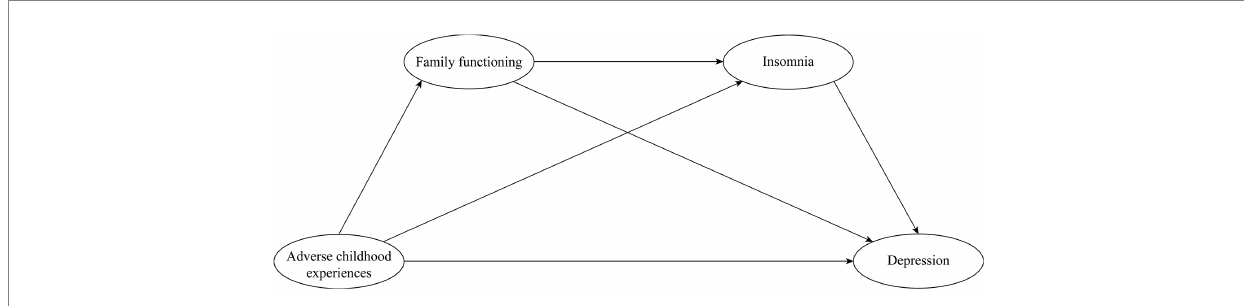
FIGURE 1 The proposed serial mediation model of the association between adverse childhood experiences (ACEs) and